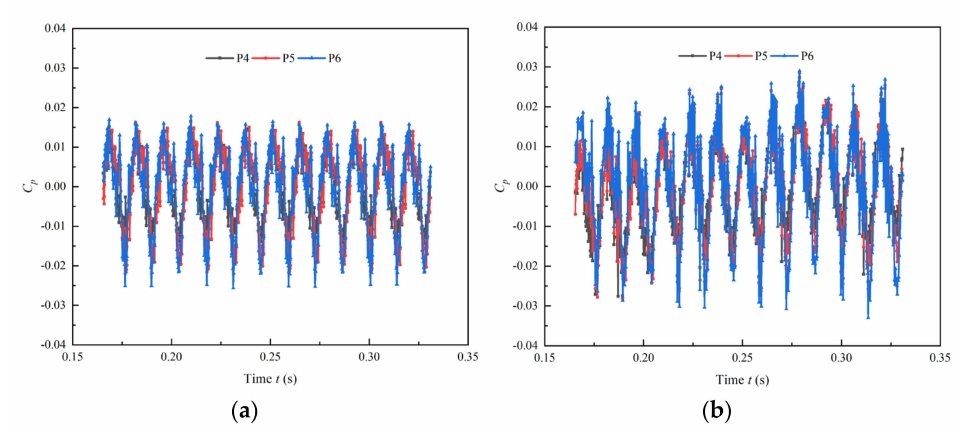
Figure 15. Time domain of pressure pulsation at impeller outlet ( Q = Q d ): ( a ) shaft front positioned tubular pump device; ( b ) shaft rear-positioned tubular pump device.